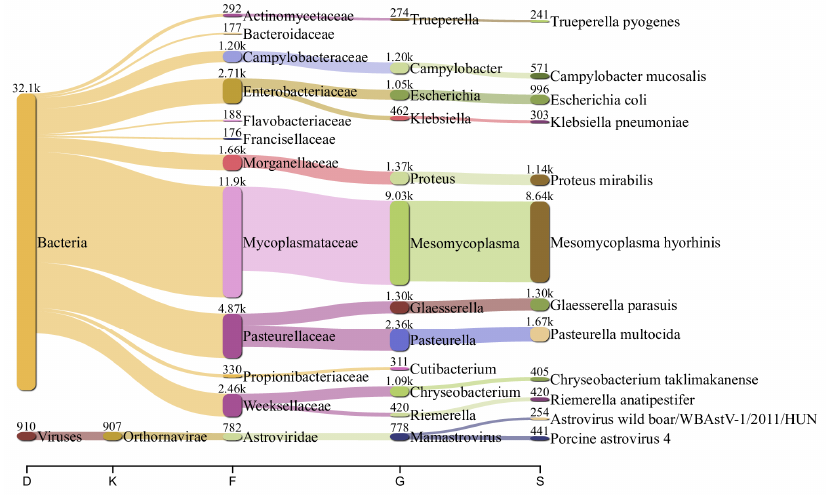
Figure 3. Flow diagram showing the most abundant viral and bacterial species (>100 reads) in the nasal swabs from sick piglets. The numbers above the nodes are the reads assigned to each taxon.